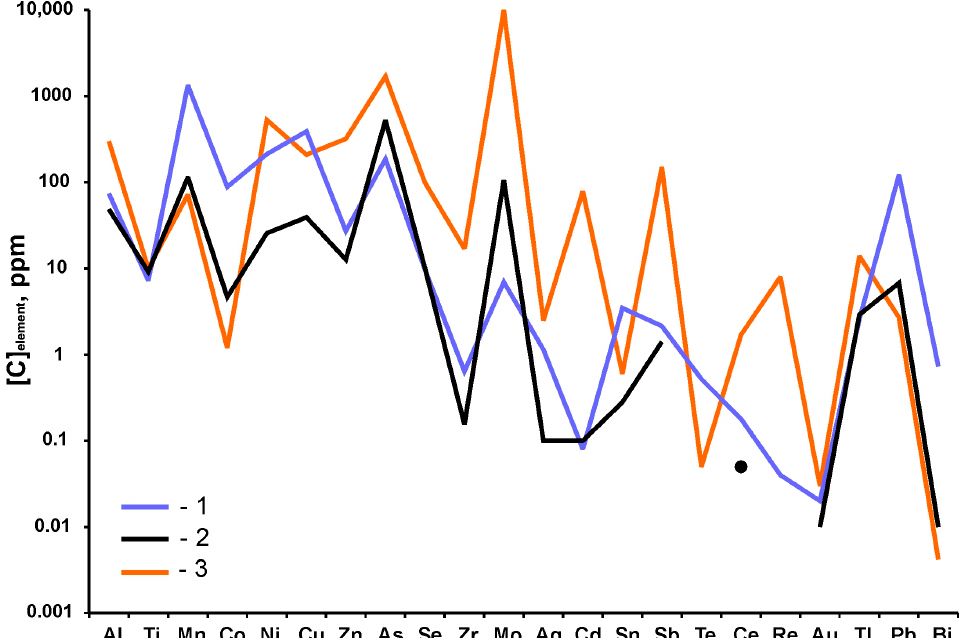
Figure 16. Trace element patterns of framboidal pyrite (1) and pyrite crystals (2) from Bulganak MV area in comparison with sea water (3) [105]. LA-ICPMS data for average composition of pyrites from Andrusov, Trubetskoy and Tischenko Hills (Tables 7 and 8). TE concentration in sea water is [C] element ·10.